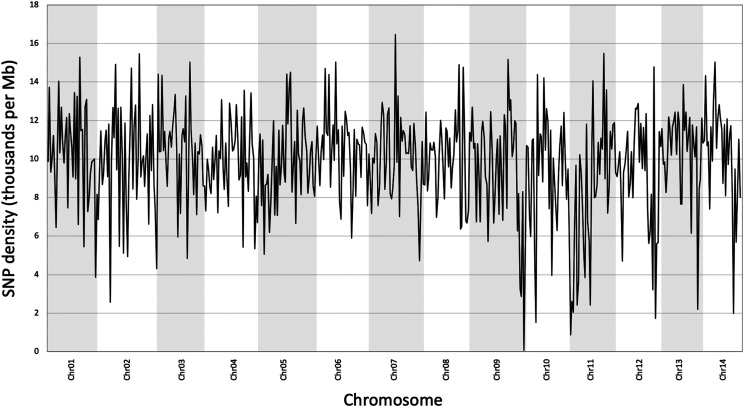
Genome wide SNP density. Thousands of SNPs per 1 Mb window, shown across each chromosome.